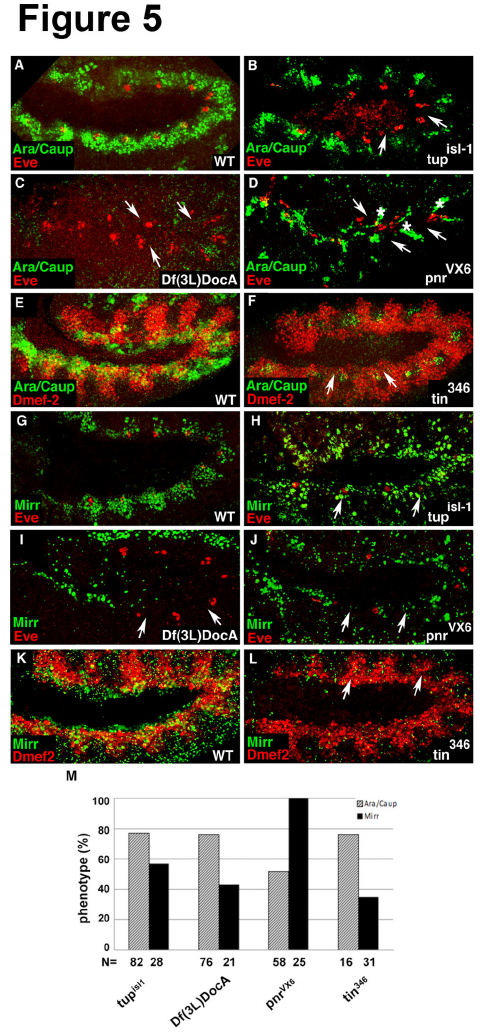
Figure 5. Mesodermal expression of Ara/Caup and Mirr depends on the crucial cardiac transcription factors tup , Doc , pnr and tin . (A, B) Ara/Caup expression is strongly reduced at the dorsal edge of the mesoderm (arrows) in tup isl-1 mutants. (C) Doc mutants (Df(3L)DocA) show a dramatic loss of Ara/Caup expression in the dorsal mesoderm (arrows). (D) In pnr VX6 mutants, Ara/Caup expression is severely reduced (arrows), but some Ara/Caup-positive cells remain in a striped pattern along the dorsal side of the embryo (asterisks). (E, F) A double immunostaining for Ara/Caup and Dmef2 reveals the absence of Ara/Caup in tin mutants (arrows). (G-J) Mirr- expressing cells are mildly reduced in tup isl-1 mutants (arrows in H) whereas a strong reduction of Mirr-positive cells is observed in Doc mutants (Df(3L)DocA) (arrows in I) and in pnr VX6 mutants (arrows in J). (K, L) tin mutants show a strong reduction of Mirr- expressing cells in the dorsal mesoderm (arrows in L). (M) Quantification of the phenotypes. The bar graph shows the percentage of embryos that were characterized by a reduction either of Ara/Caup or Mirr. Lateral views of stage 10/11 embryos are shown.